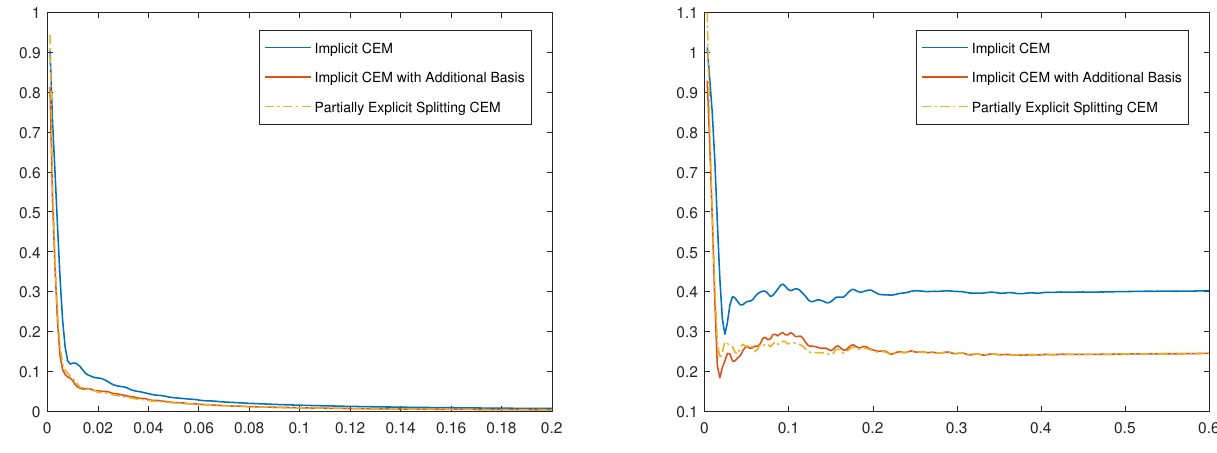
Figure 4. α = 0.05, dt = 0.003. Left : L 2 error. Right : Energy error.